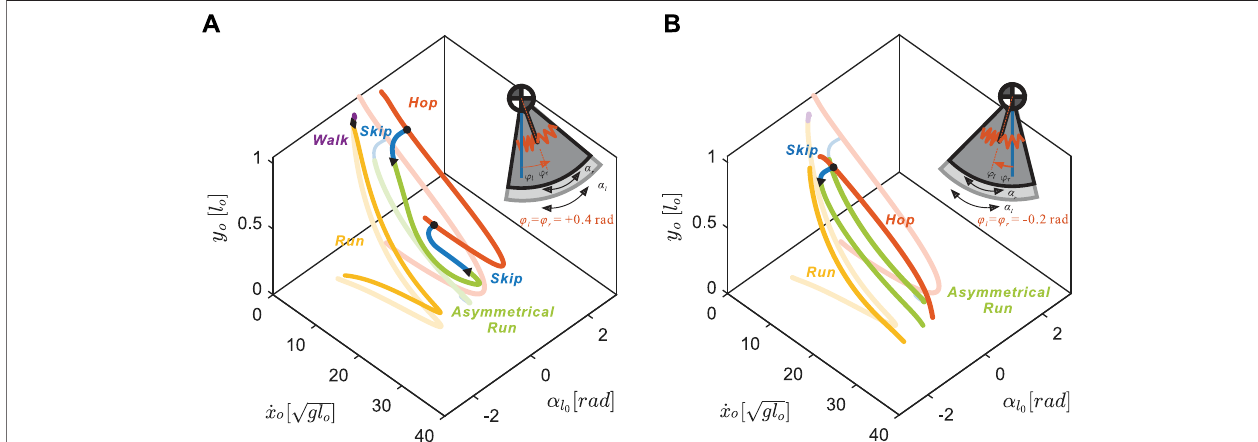
FIGURE5| Coupledchangesintheneutrallegswinganglesaffectthegaitstructureofthenominalmodel(transparentlines)onthePoincarésectionwithrespectto (A) Apositiveneutral leg swingangle, φ l = φ r =0.4rad, preservesand translates gait structure (B) A negative the apex height, y o , forward speed, _ x o , and left leg angle, α l 0 neutral leg swing angle, φ l = φ r = − 0.2 rad, alters gait structure. All other parameters including leg stiffness, k , and swing leg oscillation frequency, ω , were fi xed as described in Section 3.1. In both plots, only gaits with left-leg-advanced are shown because symmetry is preserved. The inset model diagrams show the range of leg rotational motions (dark grey sector for α r , light grey sector for α l ) and the neutral leg angles. 0 0